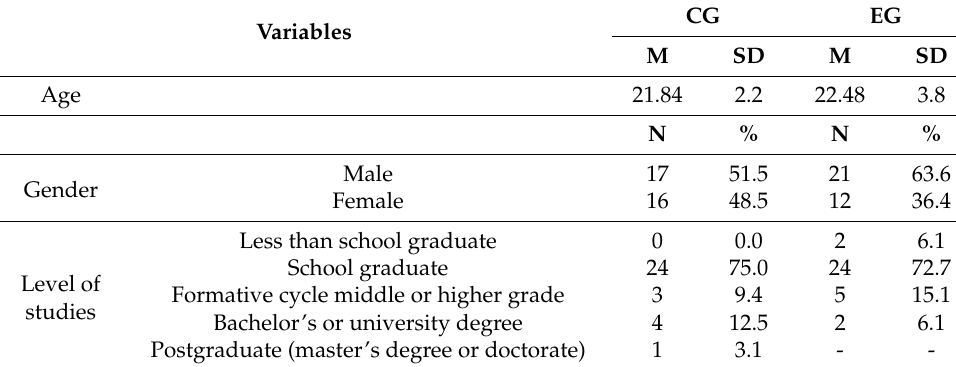
Table 1. Statistical data of the study